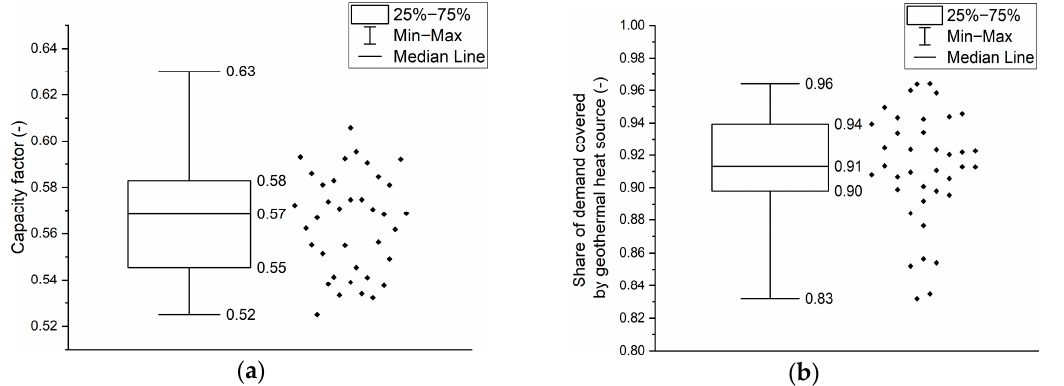
Figure 6. ( a ) Capacity factor for geothermal source and ( b ) share of energy demand satisfied by geothermal energy. The system consists of a geothermal heat source of 0.5 unit capacity, heat storage of 6 units capacity and wind power of any capacity.